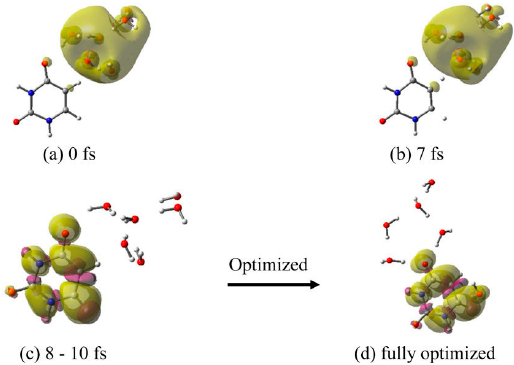
Figure 6. Total spin density plot of uracil (U)–6H 2 O • − (6H 2 O • − placed near O4-C5 site of uracil) at different times during MD simulation: ( a ) 0 fs (initial optimized starting structure for simulation), ( b ) 7 fs, ( c ) 8 − 10 fs, and ( d ) fully optimized structure. Structure d is more stable by 0.93 eV over structure